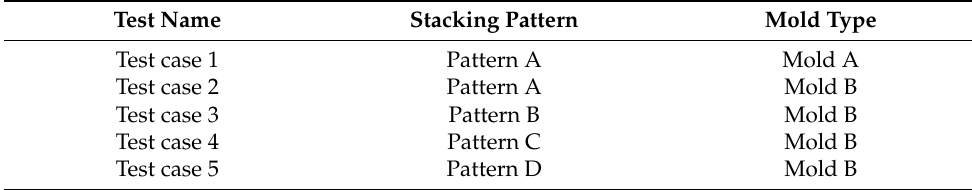
Table 2. Test cases for compression molding.